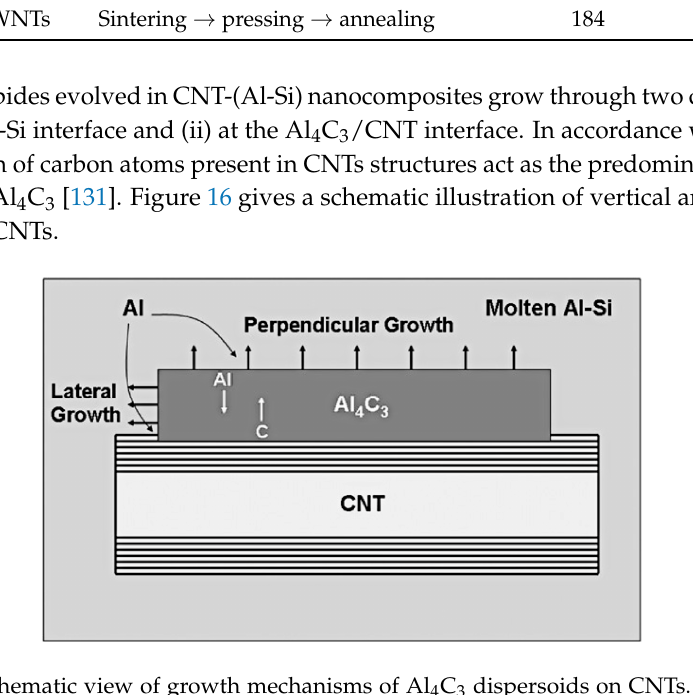
Table 3. The variation of tensile strength in CNT-dispersed Al matrix nanocomposites with the volume fraction of Al 4 C 3 precipitates (SPS: Spark plasma sintering).